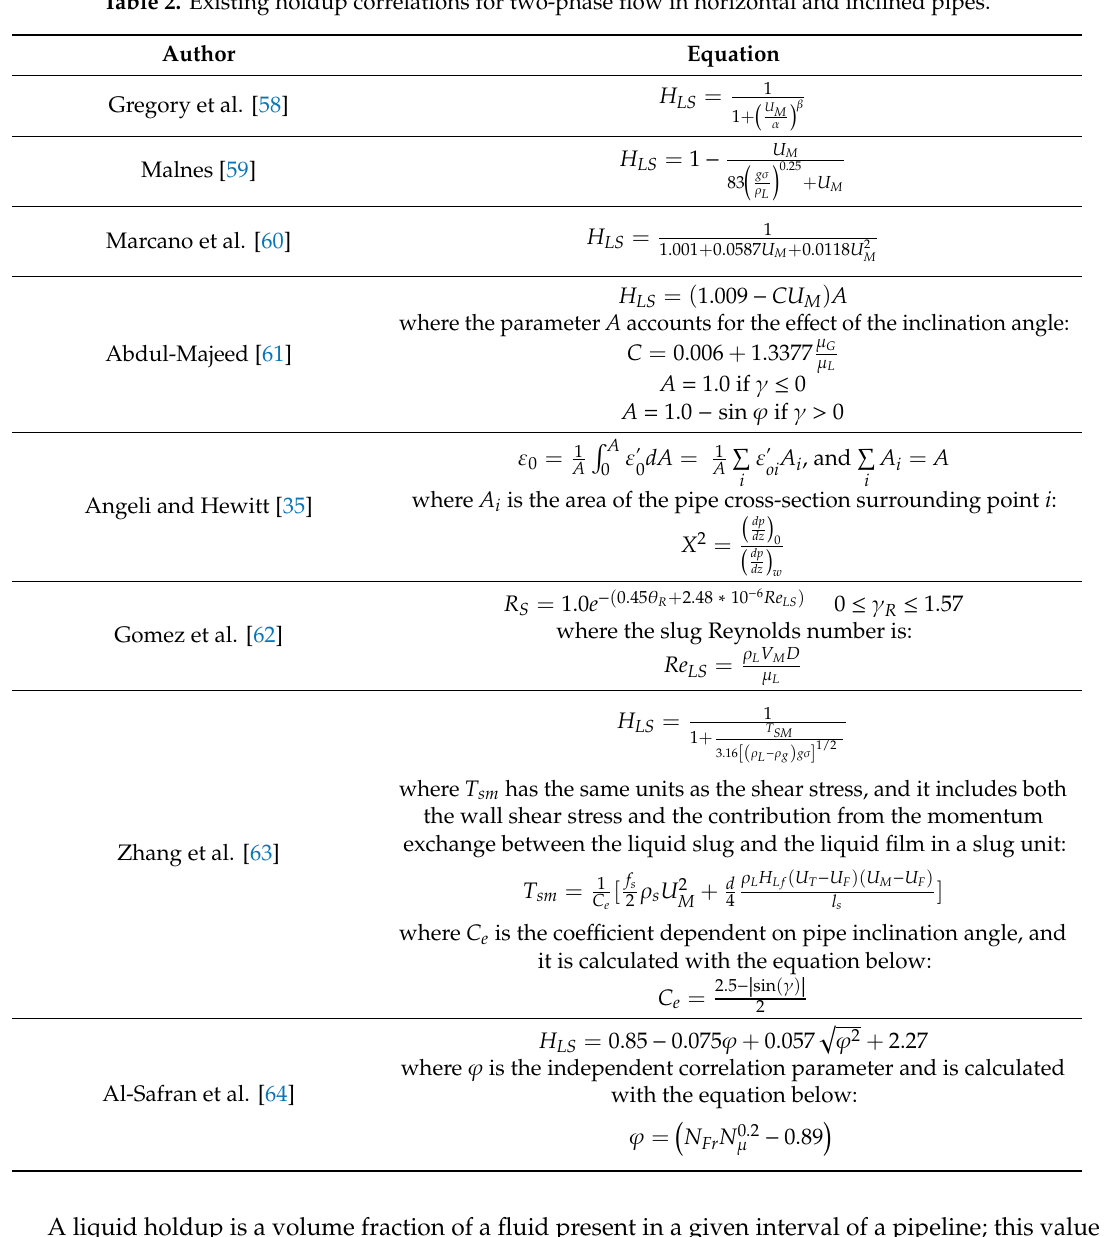
Table 2. Existing holdup correlations for two-phase flow in horizontal and inclined